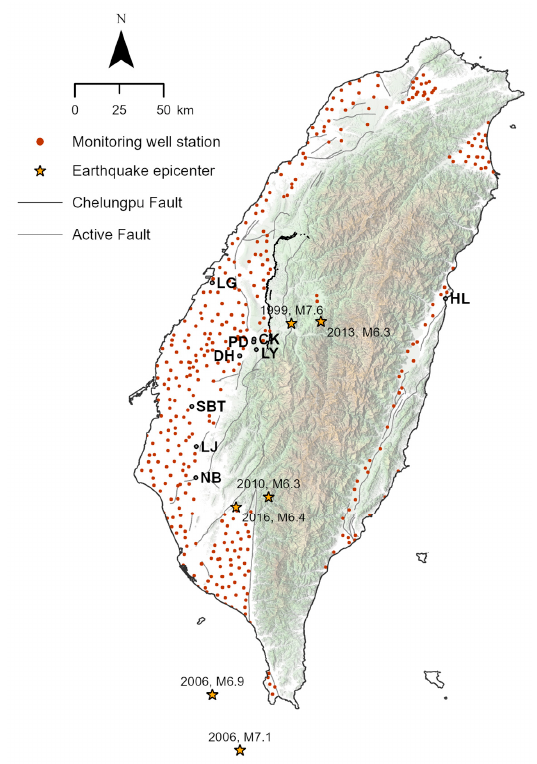
Figure 1. Map showing the epicenters of earthquakes and the locations of monitoring stations. The yellow stars represent the epicenters of the large, local earthquakes discussed in this study, and the dark-red circles represent monitoring stations in Taiwan. The characters show the locations of the nine monitoring wells used in this study.